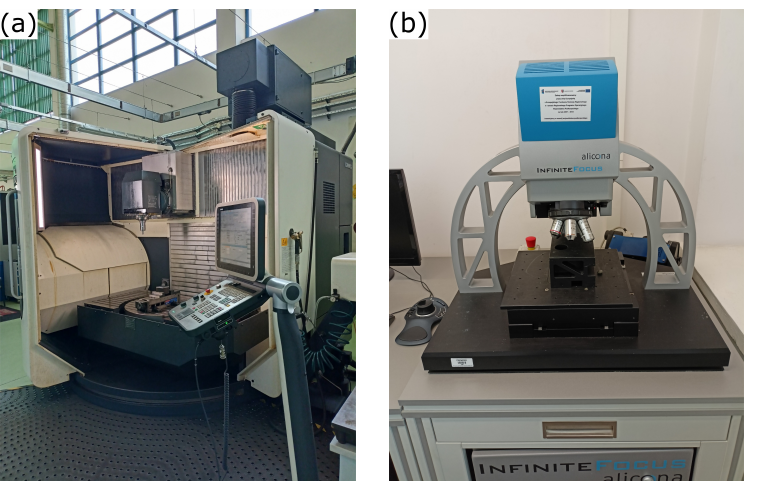
Figure 7. Research–measurement stand: ( a ) DMU 100 monoBLOCK milling center, ( b ) 3Dsystem InfiniteFocus Alicona optical microscope.